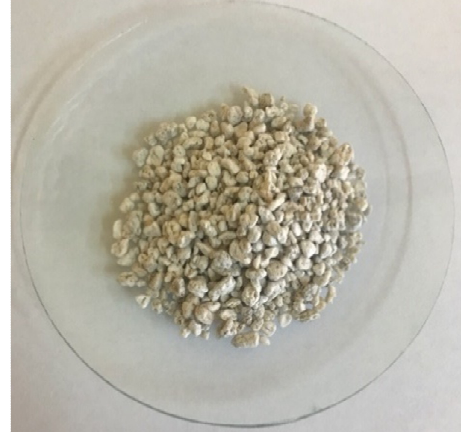
Figure 1. Image of expanded perlite. Table 1. Gradation of expanded perlite. Percentage Pass [% Mas.]